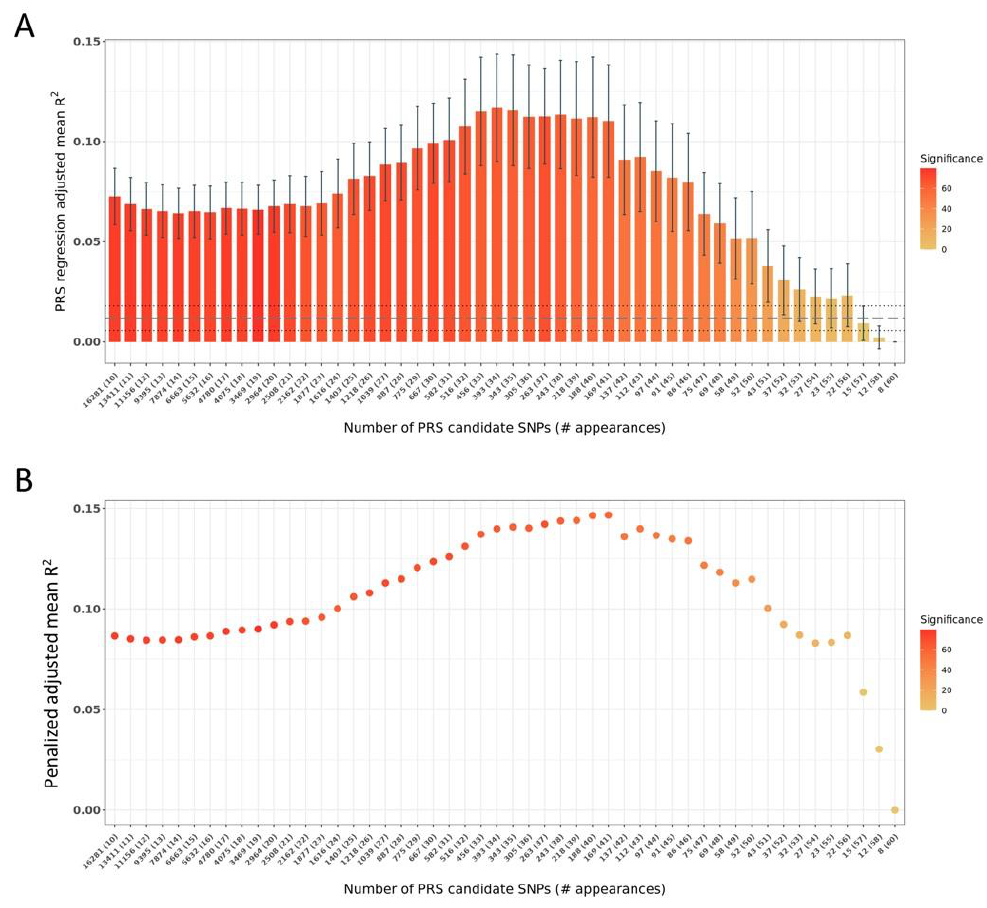
Figure 1. Mean PRS and penalized PRS R 2 for the assembled PRS candidates based on their fre- quency of appearance over 10 iterations as described in Materials and Methods. ( A ). Mean PRS R2 +/- standard deviation for PRS candidates assembled from SNPs at different frequencies of appear- ance in the PRS candidates across 100 PRS extraction iterations. The vertical axis depicts the mean adjusted PRS R 2 , while the horizontal axis depicts the number of SNPs in each PRS candidate. The number inside the parentheses next to the number of SNPs in the horizontal axis depicts the SNP frequency of appearance in the PRS. For example, 393 (34) means that the PRS at that particular R 2 consists of 393 SNPs that appear at least 34 times over 100 iterations. The color scale denotes the statistical significance (Student’s t -test p - value in −log10 scale) of the adjusted R 2 distribution over 100 de novo PRS extraction iterations (baseline R 2 ) as compared to the adjusted R2 distribution of each assembled PRS candidate in the horizontal axis. The mean baseline (derived directly from PRSice2 outcomes for each iteration) R2 is depicted with the dashed grey horizontal line, and the dotted grey horizontal lines depict the standard deviation of the former. ( B ). Mean penalized ac- cording to the number of SNPs PRS R 2 .